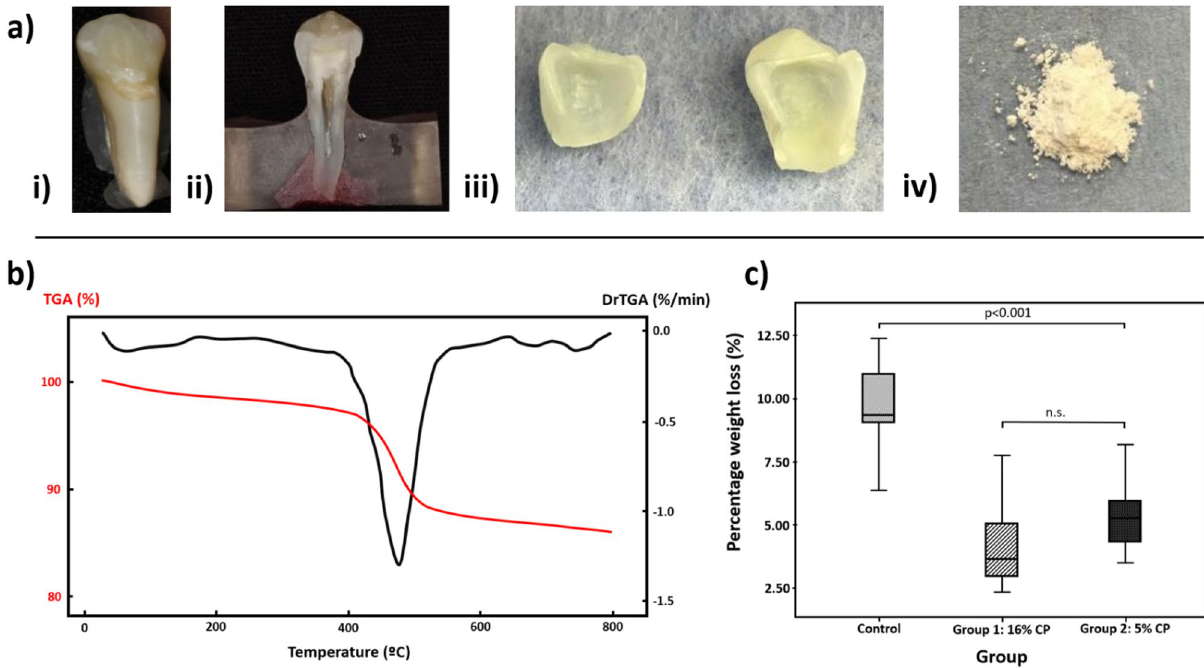
Figure 2. Enamel-protein (weight) ratio analysis pre and post-whitening. ( a ) Sample preparation for enamel- protein (weight) ratio Analysis. (i) Intact tooth sample. (ii) Longitudinally sectioned tooth into buccal/lingual half. (iii) 0.3–0.5 mm thick enamel shell. (iv) Enamel shell fine powder for thermogravimetry testing. ( b ) TGA curve (red) and its derivative (black) showing the mass change in enamel as a function of temperature ramp. (c ) Box and Whisker plot, showing the range of TGA results in a percentage of weight loss for each group. A significantly lower (p < 0.001) enamel-protein content (by weight) of the treatment groups compared to the control. Artificial